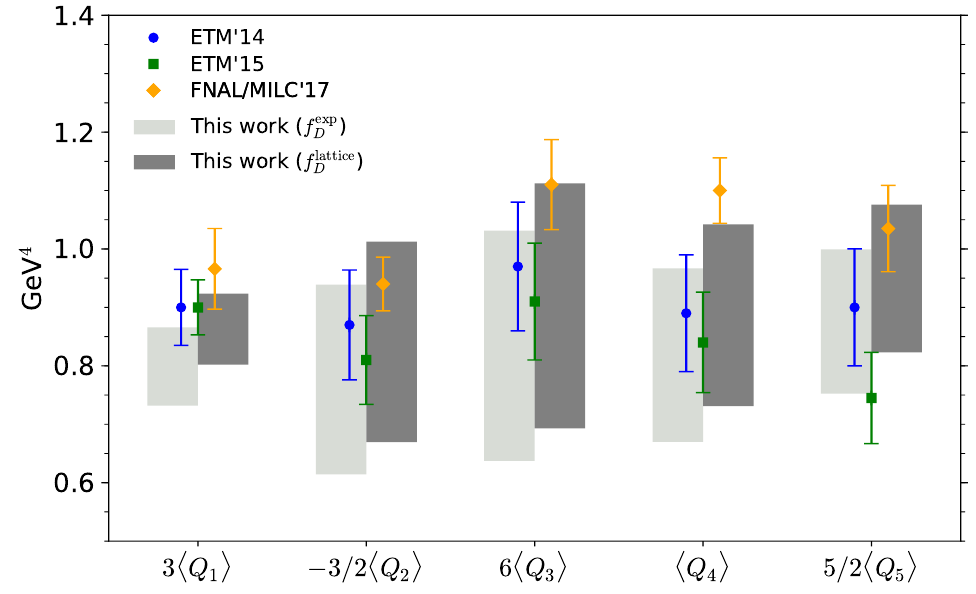
Figure 7 . Comparison of our results for the (cid:1) C = 2 matrix elements at the scale 3 GeV to the lattice values of ETM’14 [30], ETM’15 [31] and FNAL/MILC’17 [32] The values for the matrix elements of the ETM collaboration are extracted from (cid:12)gure 16 of